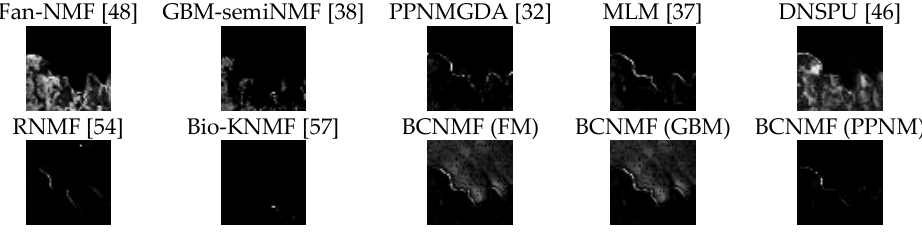
Figure 16. The differences in reconstructed images between the FCLS and nonlinear spectral unmixing algorithms.